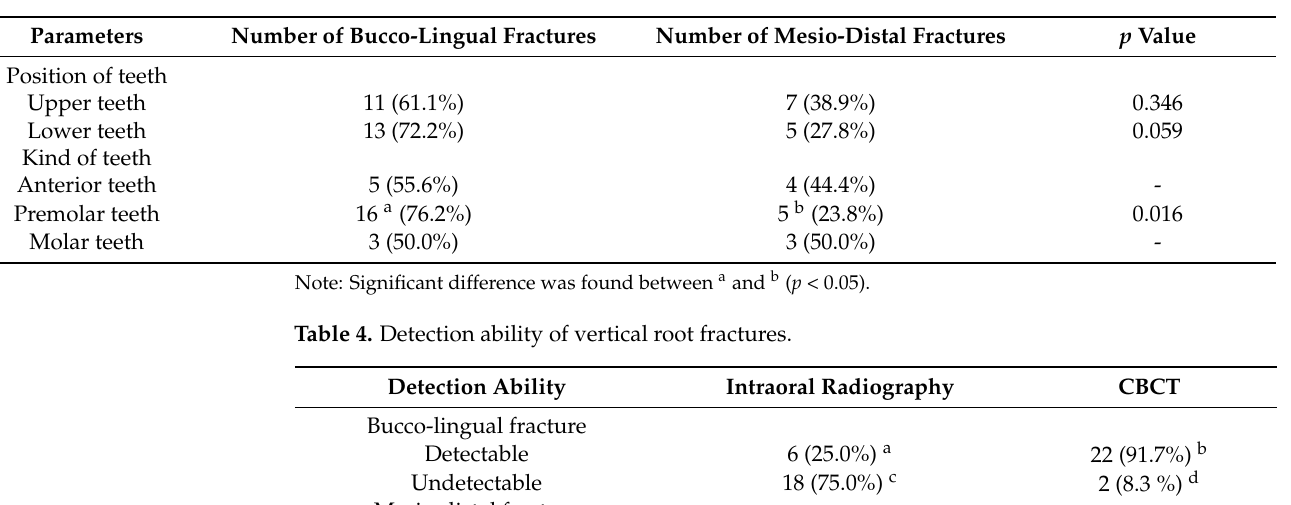
Table 3. Bucco-lingual and mesio-distal fractures in 36 vertical root fractures.